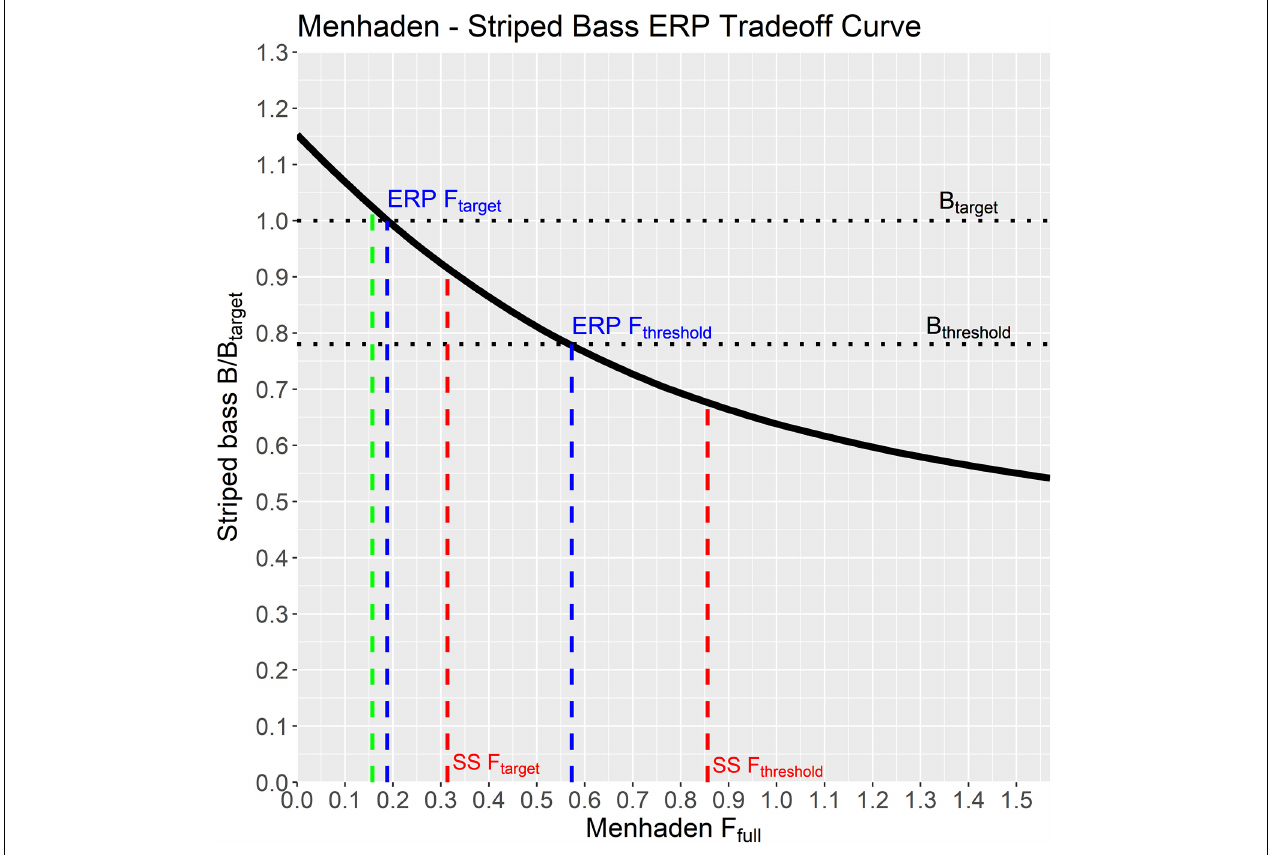
FIGURE 5 | Equilibrium striped bass biomass ratio when fished at F target = 0.2, over a range of menhaden F rates, generated by the NWACS-MICE Ecosim model. The solid black line is the tradeoff curve used to establish the ecological reference points (ERPs). The ERP F target and ERP F threshold are the menhaden F rates where the curve crosses the biomass target and threshold, respectively. Target and threshold F rates from the single-species (SS) stock assessment are included for comparison along with the current menhaden F rate (green